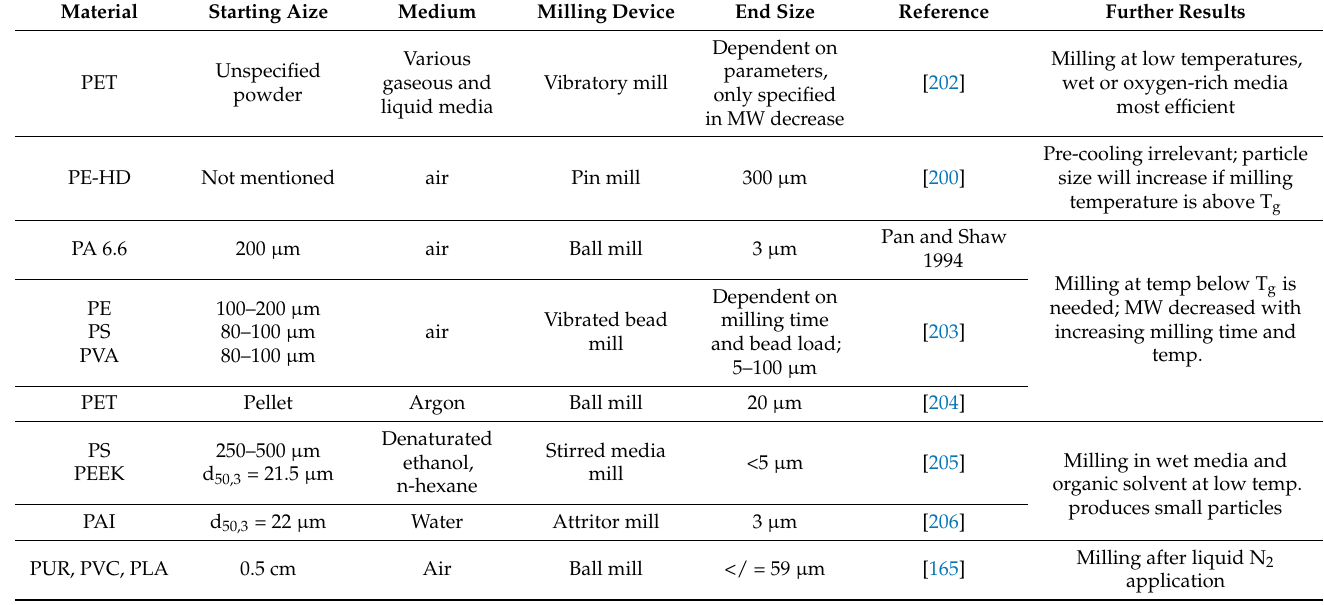
Table 4. Comminution of thermoplasts: list of parameters and results of some publications.